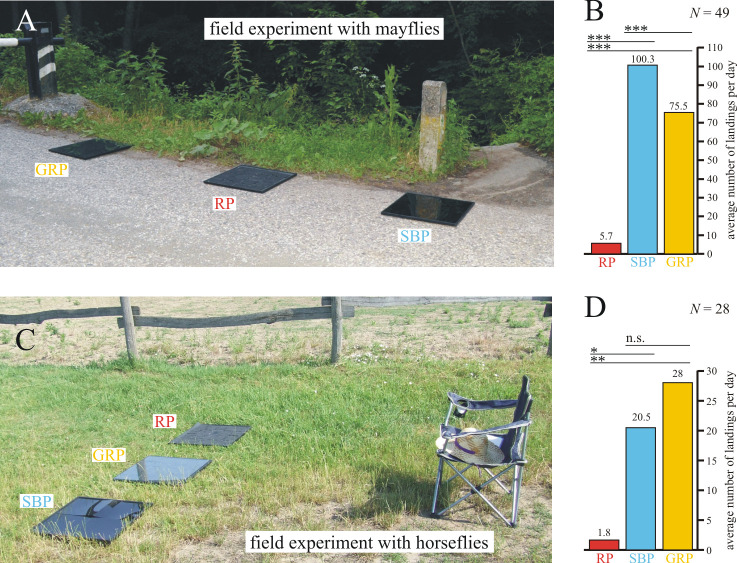
Arrangements and results of the field experiments with mayflies and horseflies.The experimental site of the field experiments with mayflies (A) and horseflies (C), including the arrangement of the three test surfaces, and the average daily numbers of landings (B, D) with the results of the Wilcoxon signed-rank test. RP: rose petal, GRP: glass-covered rose petal, SBP: smooth black plastic, N: number of observations per category, n.s.: not significant with p > 0.05, *: 0.001 < p < 0.05, **: 0.0001 < p < 0.001, ***: p < 0.0001.